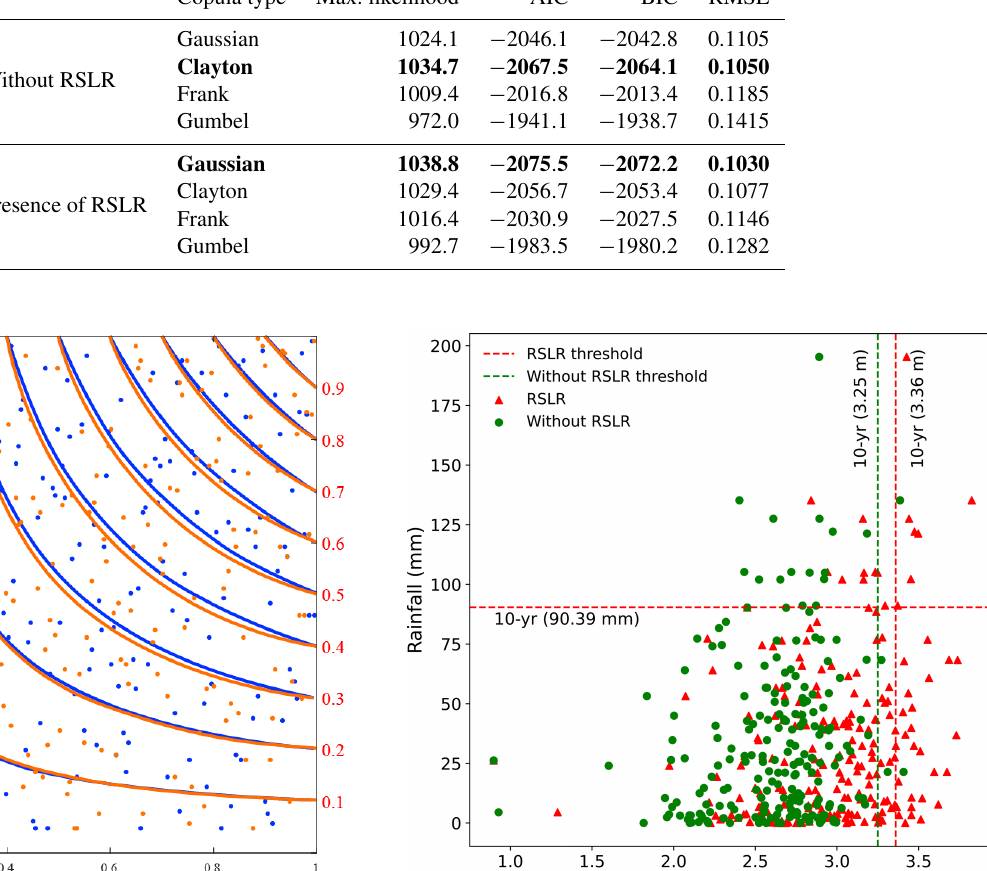
Table 1. Performance measures of the estimated copula functions (data of functions selected for this study are indicated in bold). Copula type